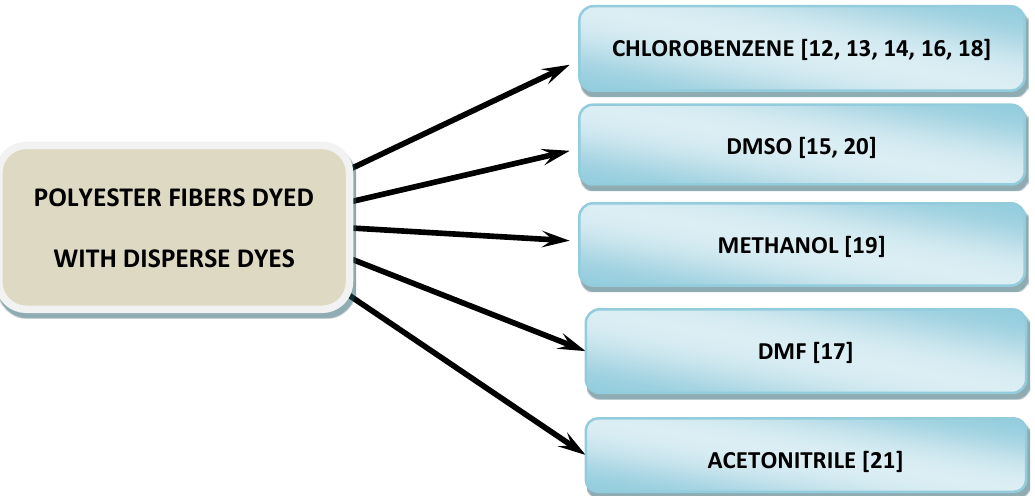
Figure 2. Solvents applied for the extraction of disperse dyes from dyed polyester fibers.